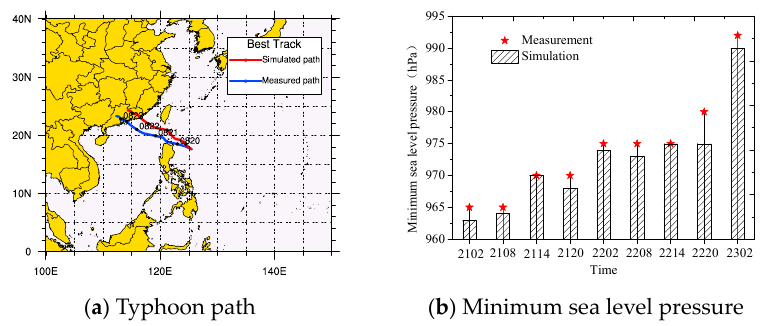
Figure 6. Typhoon path and minimum sea level pressure in the simulation process.